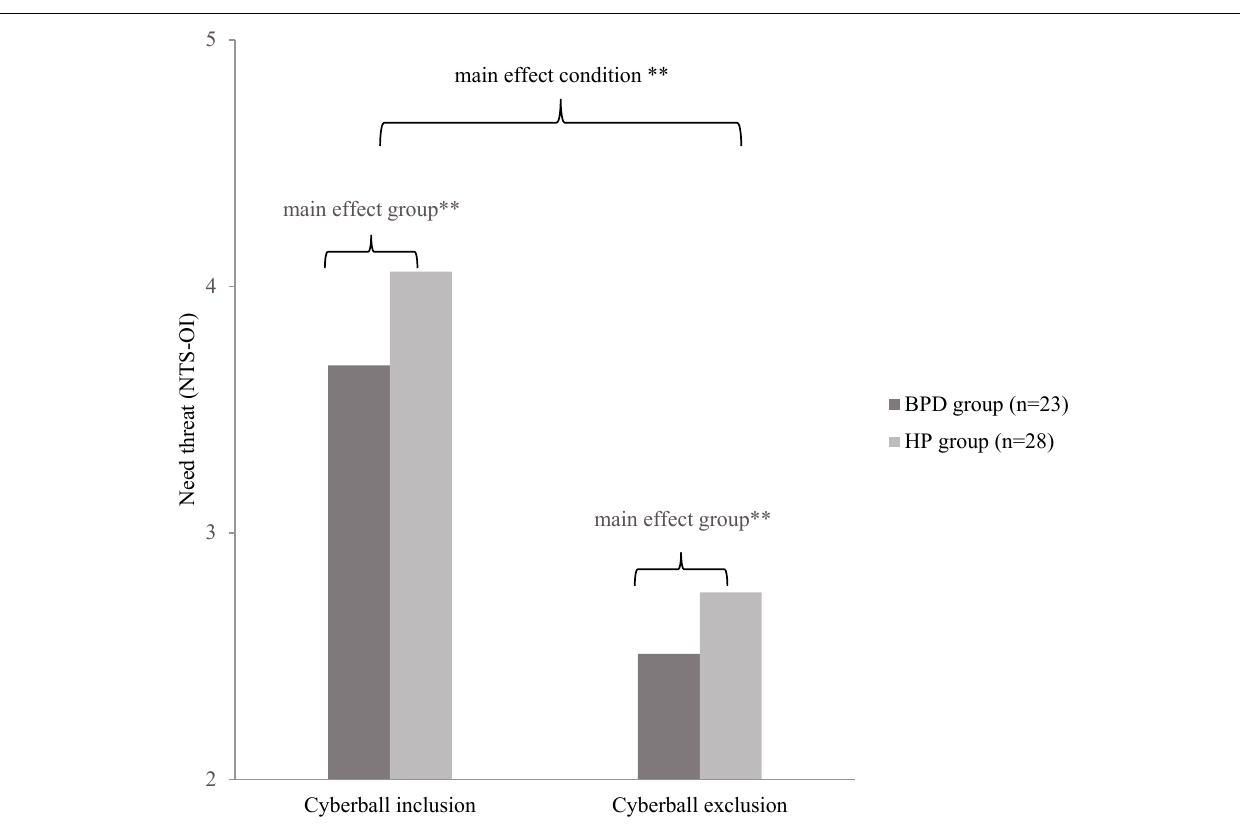
the group as whole. For the significant associations,